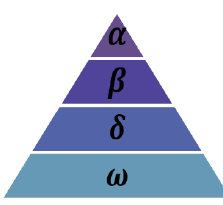
Figure 7. Grey wolf social structure (dominance decreases from to